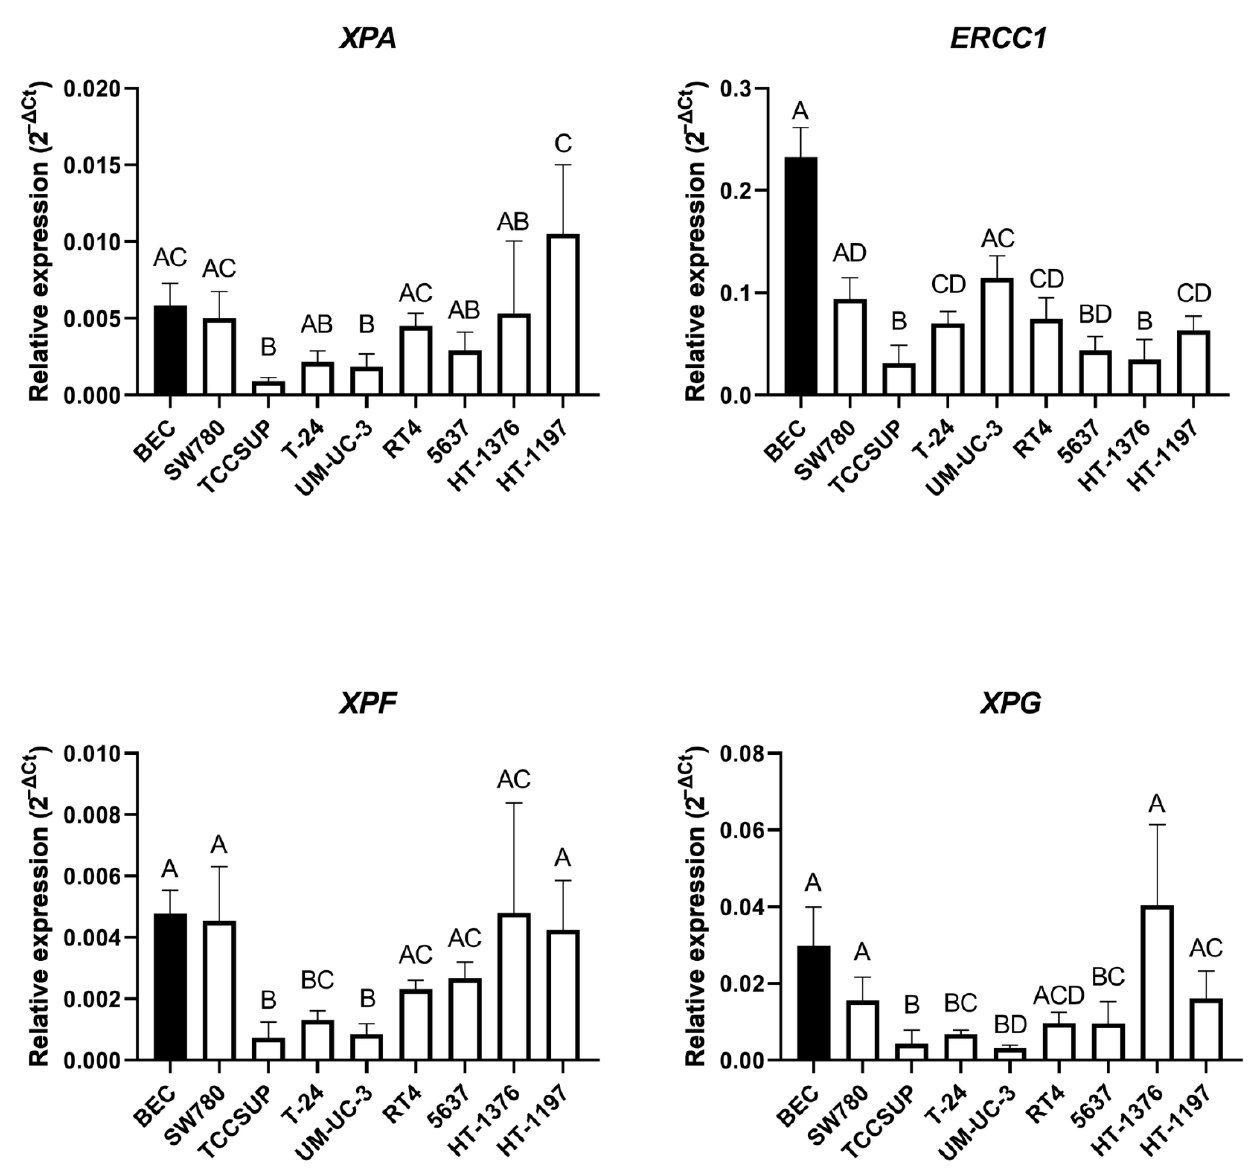
Figure 4. Relative basal gene expression of the selected NER factors in the UCC lines and BEC. Relative mRNA expression of XPA ( upper panel left ), ERCC1 ( upper panel right ), XPF ( lower panel left ) and XPG ( lower panel right ). Values are reported as the mean with a 95% confidence interval from three biological and three technical replicates. Columns marked with the same letters did not show a statistically significant difference, while columns marked with different letters indicate a statistically significant difference using one-way ANOVA with Tukey post-hoc test for multiple comparisons.